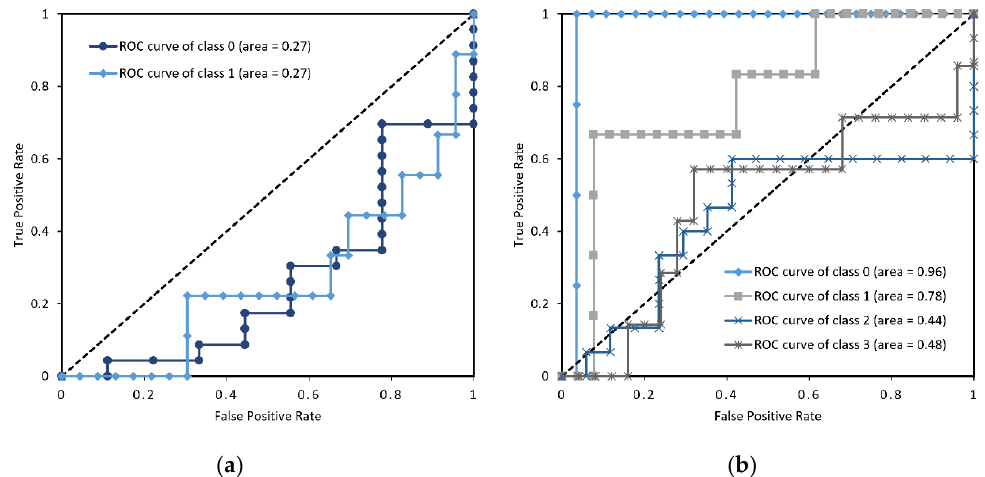
Figure 5. ROC curve and AUC of learning model: ( a ) 2-class classification result (disease); ( b ) 4-class classification result (severity).